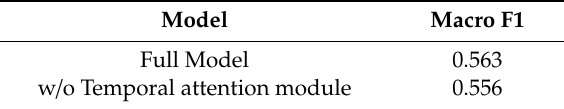
Table 2. Ablation results on the WebQuestions test set.